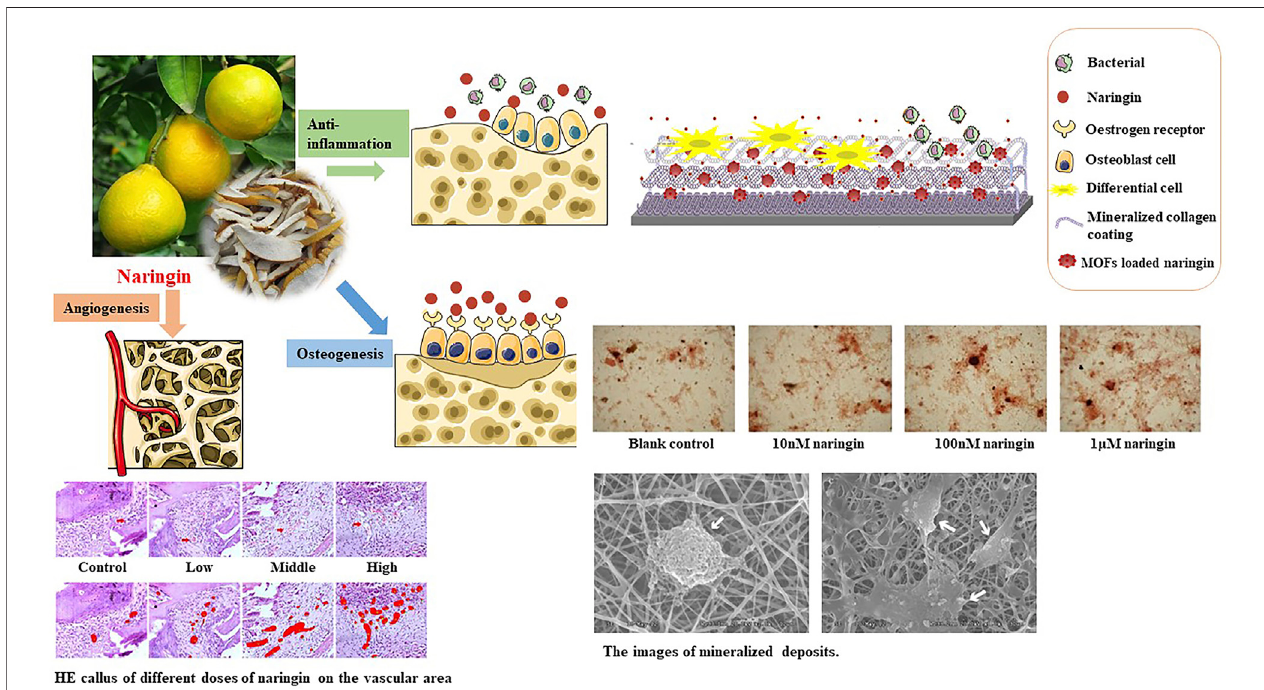
FIGURE 3 | Illustration of naringin: the origin and biomedical researches. Naringin is a natural fl avonoid present in several fruits of the Citrus genus. As a fl avonoid with multiple therapeutic targets in orthopedic tissues, naringin exhibits osteogenic, angiogenic, and anti-in fl ammation effects in preclinical studies.